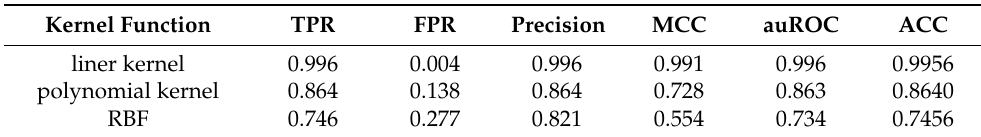
Table 3. The prediction results of the best feature subset of monoTriKGap under different kernel functions of support vector machine. Kernel Function TPR FPR Precision MCC auROC ACC liner kernel polynomial